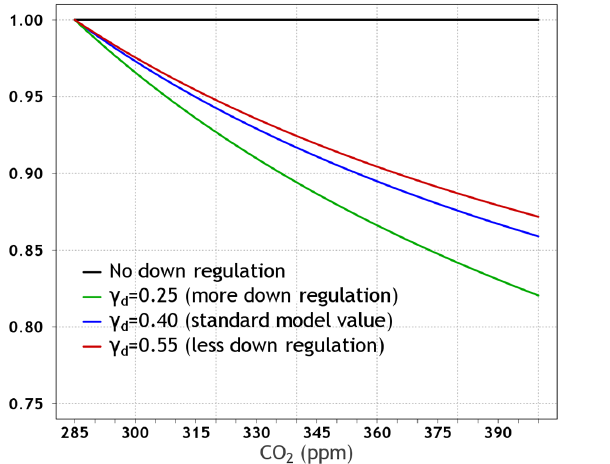
Figure 1. The behaviour of terrestrial photosynthesis down- regulation scalar ξ(C) (Eq. 12) for γ p = 0 . 95 and values of γ d equal to 0.25, 0.4 and 0.55 that are used in CanESM4.2 simulations.